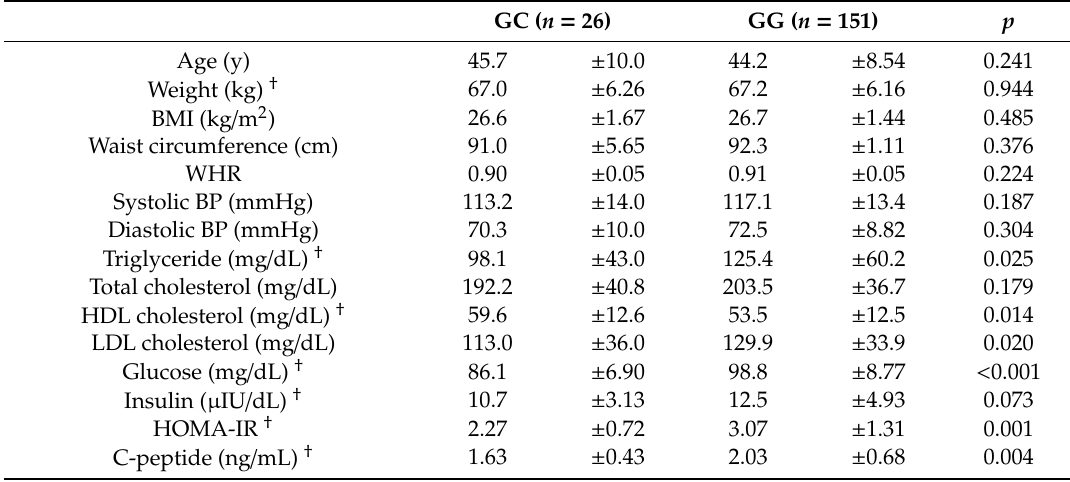
Table 2. Biochemical and clinical characteristics of female subjects with obesity according to the